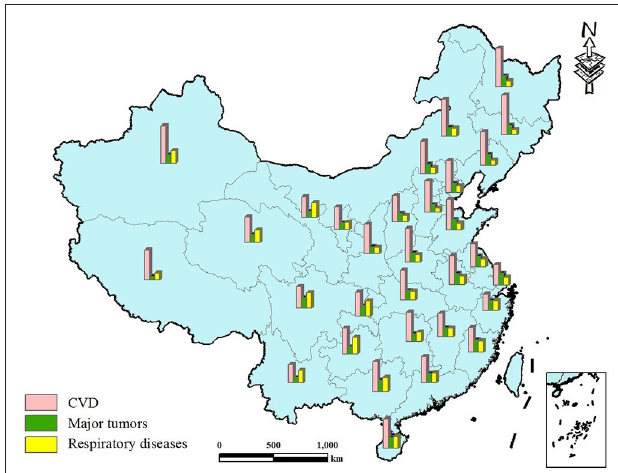
FIGURE 3 | Each disease’s percentage of total age-standardized mortality